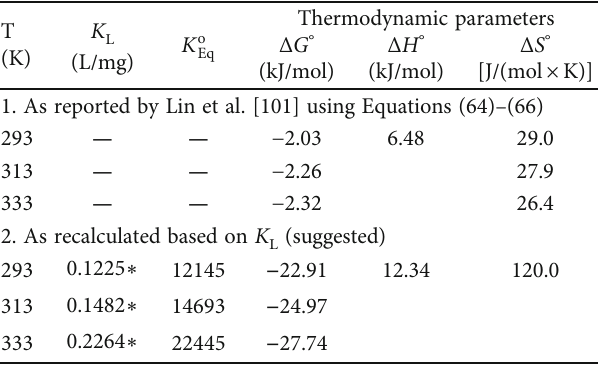
Table 9: Thermodynamic parameters of the adsorption process of phenol onto